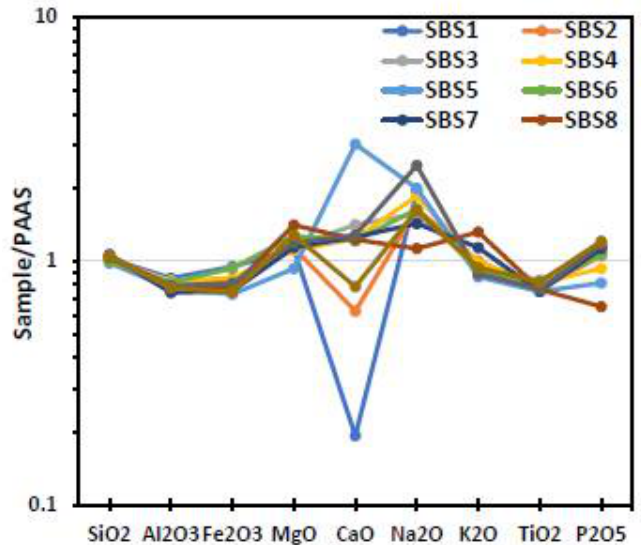
Figure 5. Major elements in black mudstones normalized to PAAS.